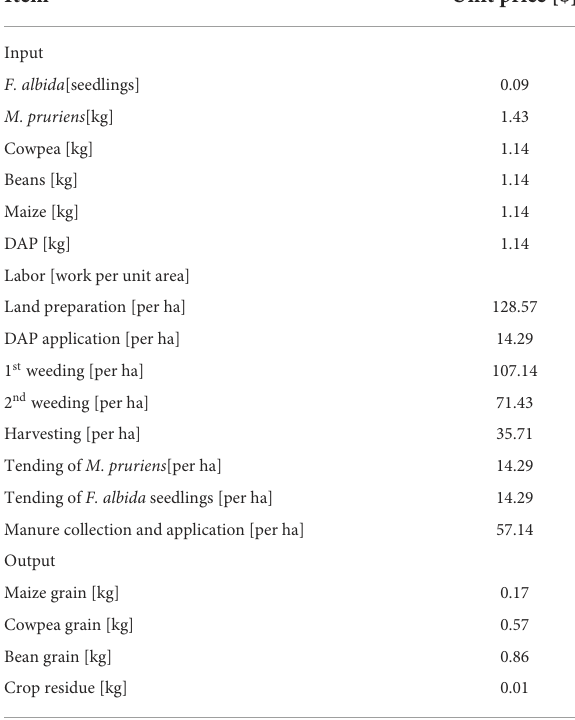
TABLE 3 Prices of inputs and outputs considered in the study in